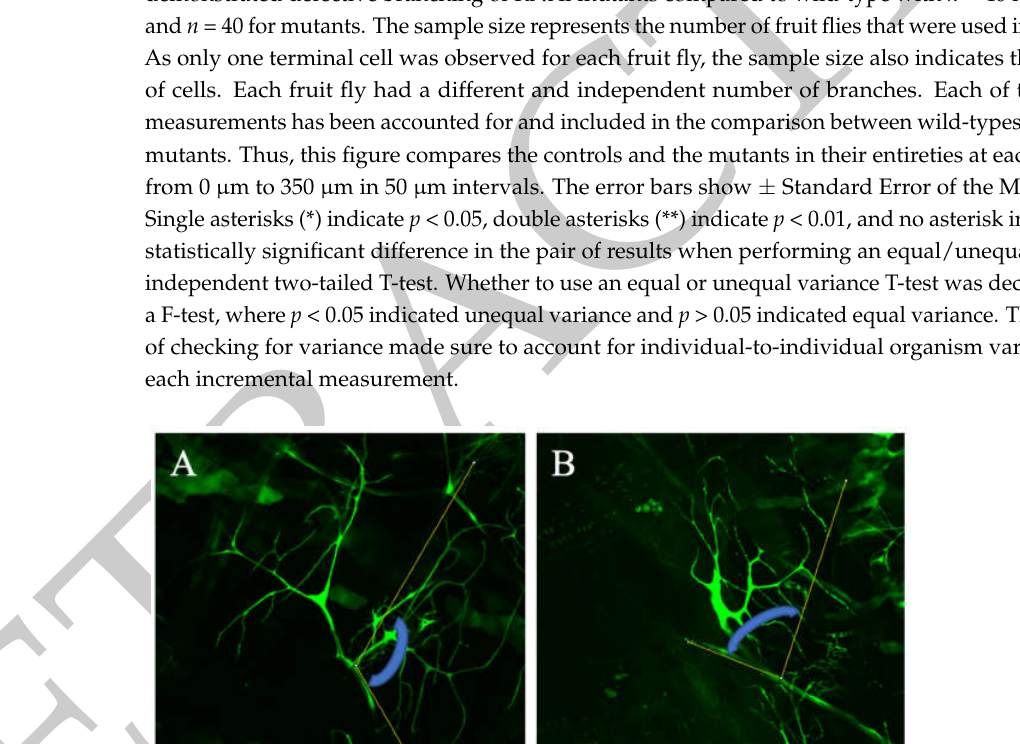
Table 1. Angle° data for branching morphogenesis of controls and mutants.